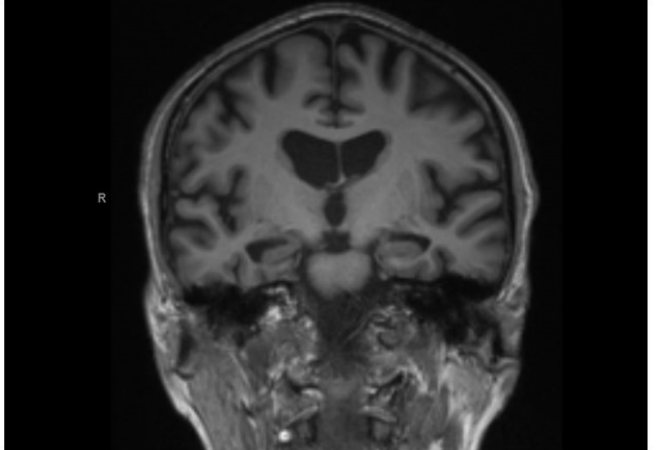
Figure 1. Magnetic resonance imaging picture in a patient enrolled in the study with abnormal MTA score.